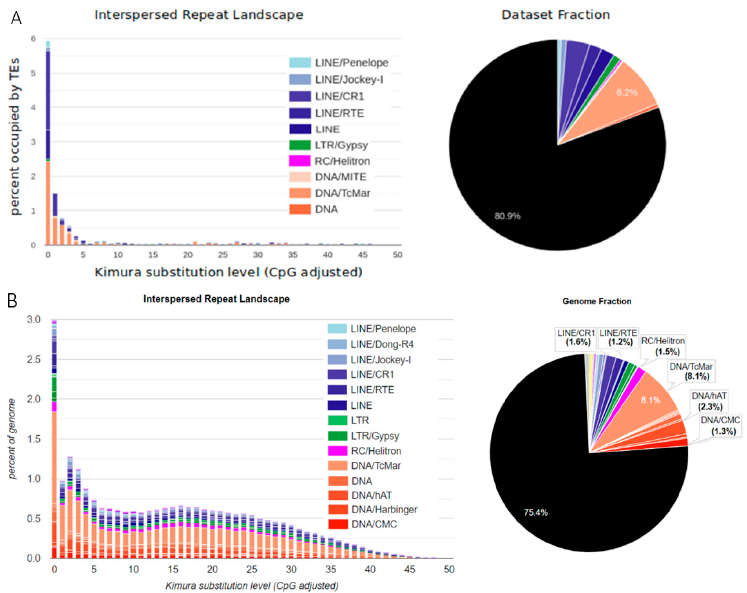
Figure 3. Landscape divergence plots (left hand side) and genome occupancy by known transposable elements (TEs) (right hand side) in D. stevensoni . Divergences were calculated as Kimura substitution levels with adjusted CpG. ( A , top ) TEs in fosmid DNA sequence data. Genome fraction of TEs was calculated after merging RepeatMasker and Censor outputs. ( B , bottom ) TEs in the preliminary draft genome assembly [45]. The plot was constructed using the REPET library obtained with the Illumina assembly. The pie chart shows genome occupancy for TE categories occupying more than 1% of the